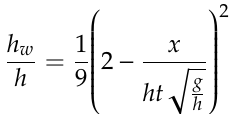
(cid:112) = 7, 8.75, g / h with x h